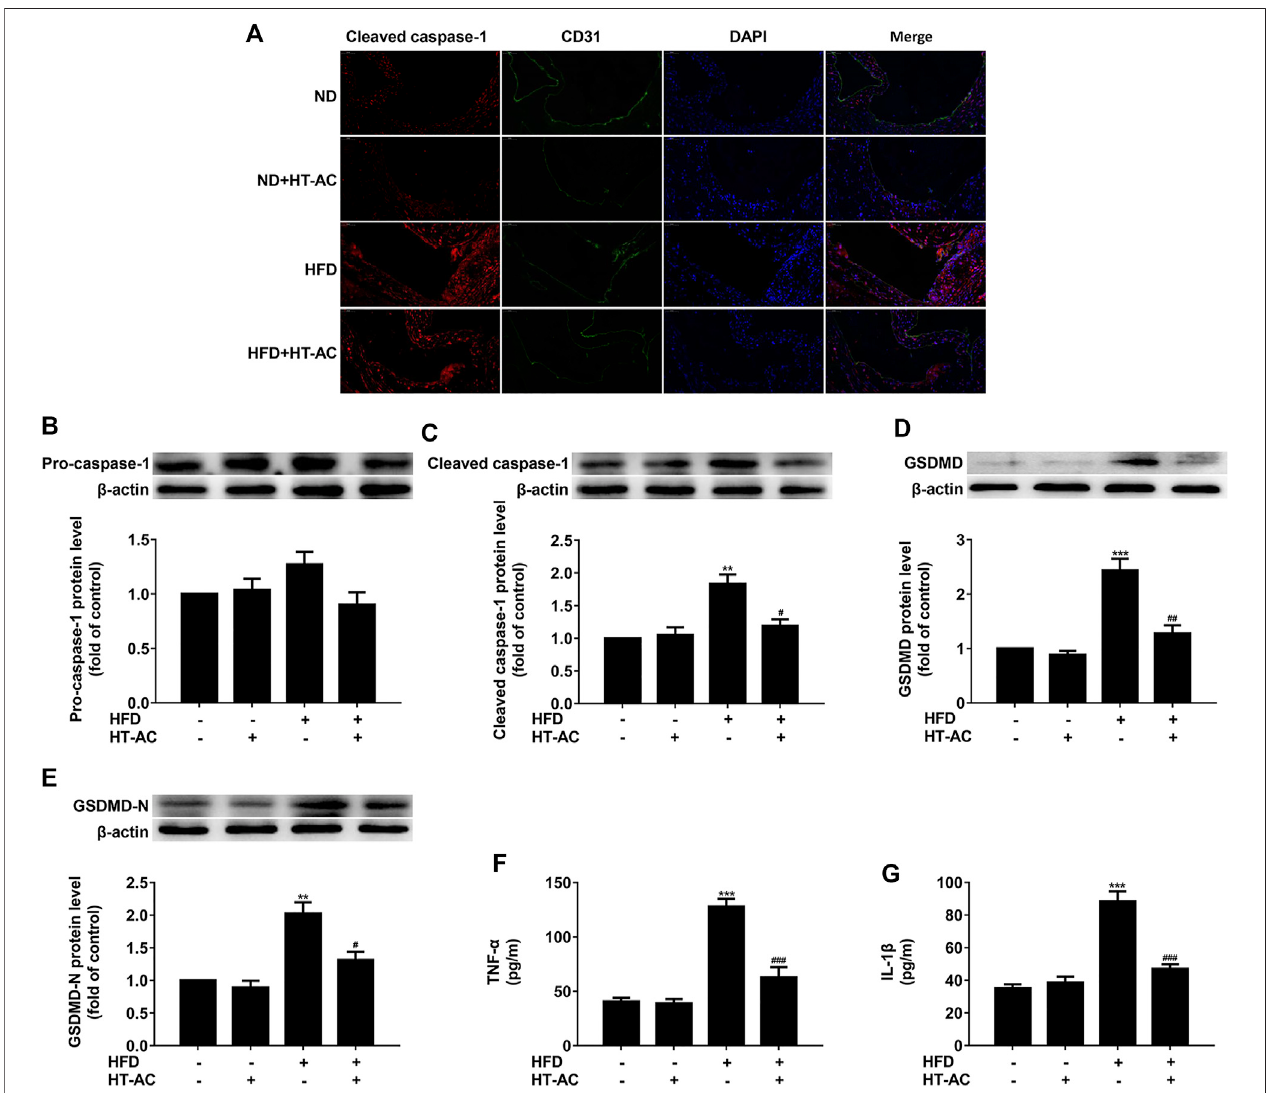
FIGURE 2 | HT-AC inhibited pyroptosis in the aortic intima of HFD-fed ApoE − / − mice (A) Frozen sections of aortic root were stained for activated caspase-1 (cleavedcaspase-1)(stainedinred).ThenucleiwerestainedbluewithDAPI.CD31(stainedingreen)wasusedasanendothelialmarker.Scalebarindicates50 μ m (B – E) Theproteinexpressionsofpro-caspase-1,cleavedcaspase-1,GSDMDandGSDMD-NweredeterminedbyWesternblotting (F,G) TheconcentrationsofTNF- α andIL- 1 β in the serum were determined by ELISA. ** p < 0.01, *** p < 0.001 vs. ND group; # p < 0.05, ## p < 0.01, ### p < 0.001 vs. HFD group. Results are expressed as mean ± SEM ( n (cid:2)